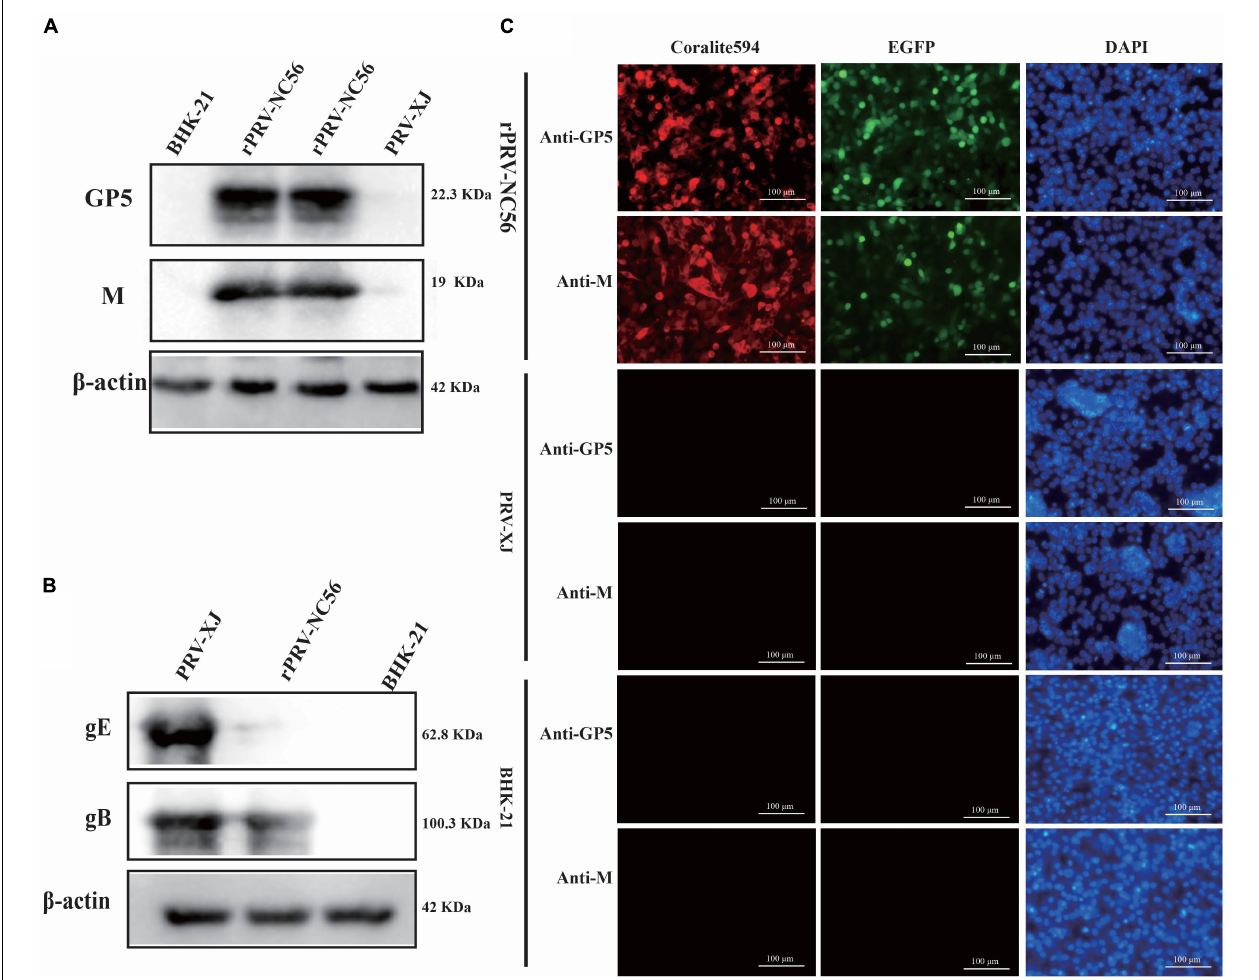
FIGURE 2 | Western blot and immunofluorescence assay (IFA) identification of recombinant pseudorabies virus rPRV-NC56. (A) Western blotting analysis of NADC30-like porcine reproductive and respiratory syndrome virus (PRRSV) GP5 and M proteins in BHK-21 cells infected with rPRV-NC56. (B) Western blotting analysis of PRV gE and gB protein in BHK-21 cells infected with rPRV-NC56. (C) Detection of the GP5 and M protein expression through an IFA. Green, EGFP; red, GP5 protein-positive cells; blue, DAPI-stained BHK-21 cell nucleus. DAPI, 4 (cid:48)